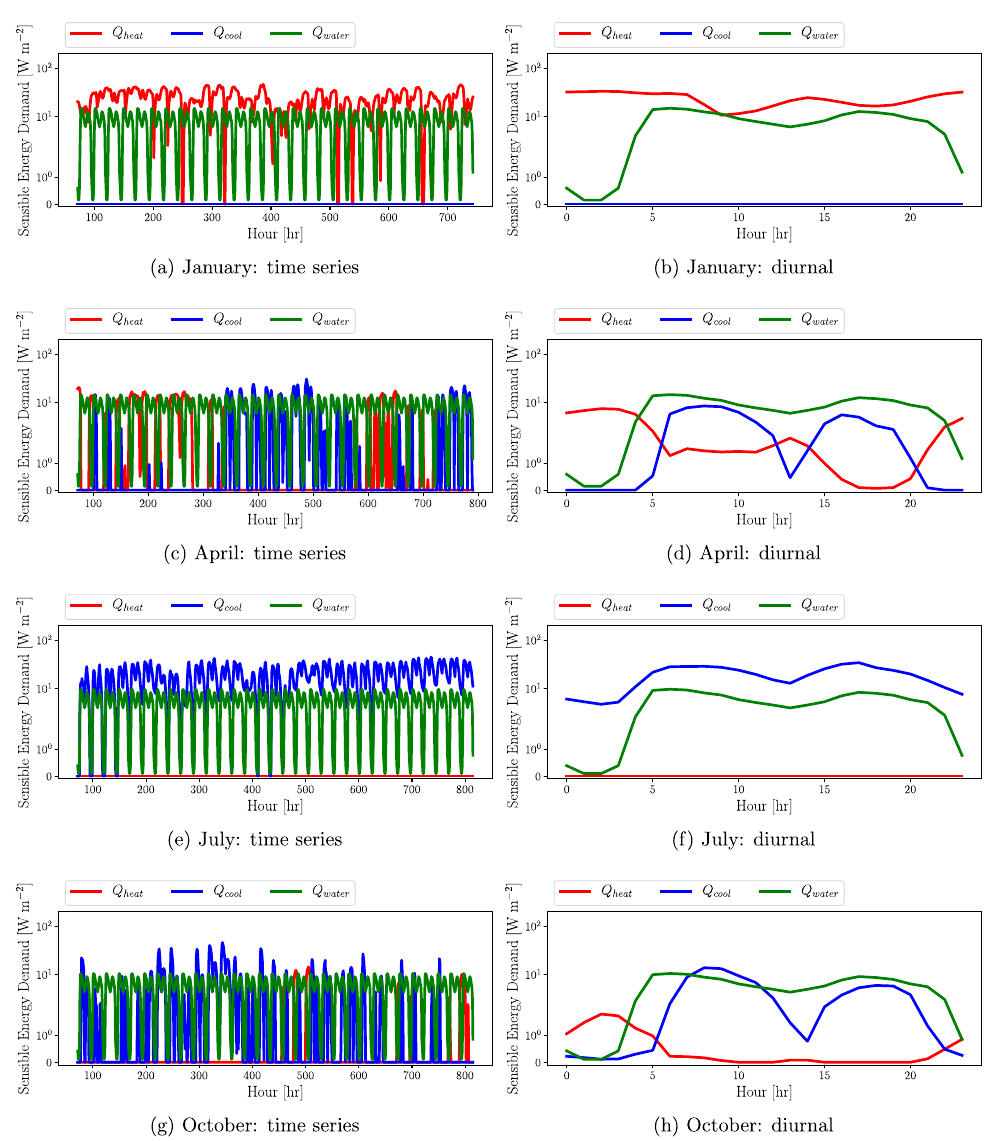
Figure A1. Building energy demand: time series ( a , c , e , g ) and diurnal ( b , d , f , h ) variation of sensible heating Q heat , sensible cooling Q cool , and water heating Q water demands, all in [W m − 2 ]; all energy demands reported per unit building footprint area; and diurnal variation is shown for the mean values at every diurnal